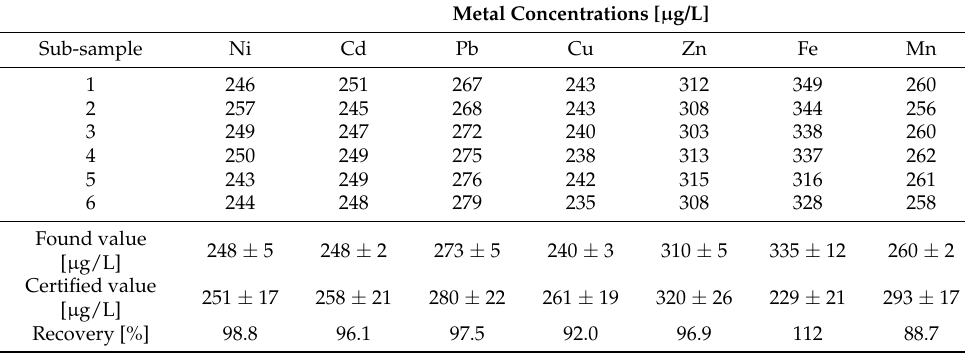
Table A1. Results of reference material analysis (n =